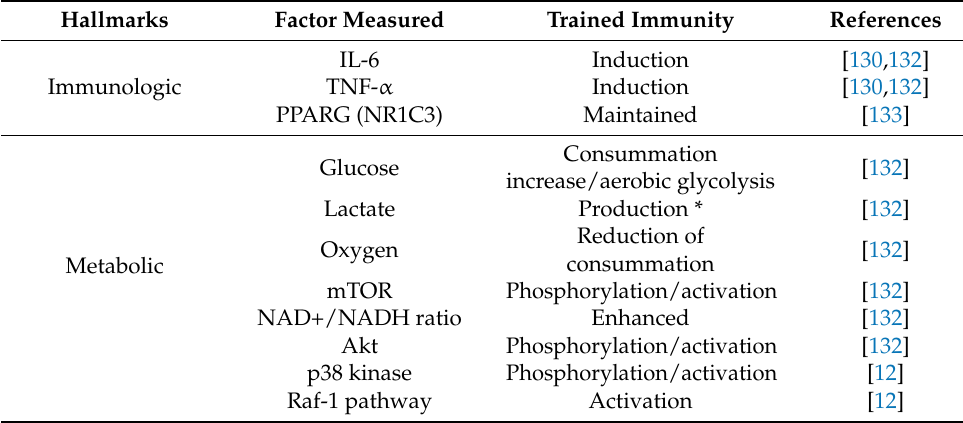
Table 1. Trained immunity hallmarks (non-exhaustive